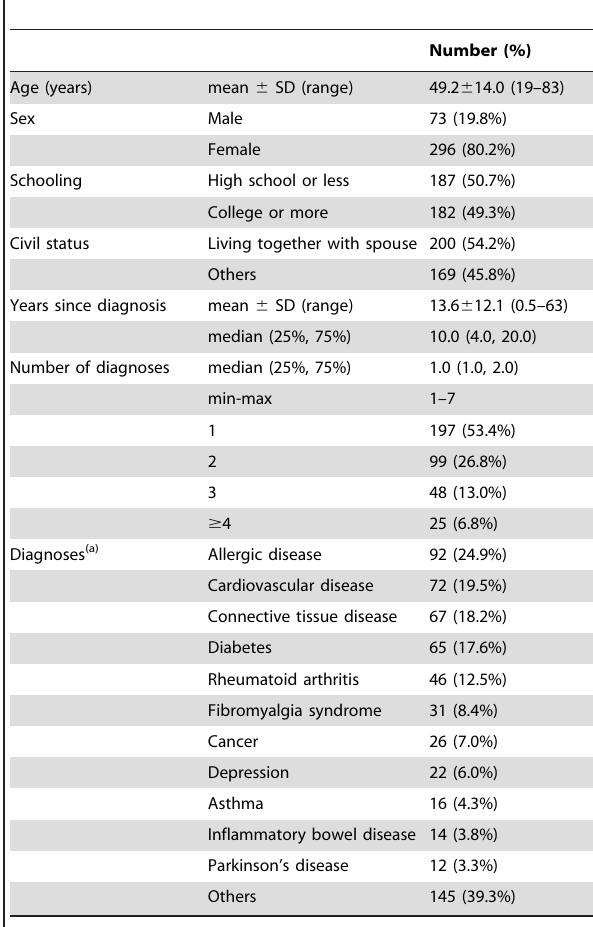
Table 1. Demographic and clinical characteristics of the participants in this study